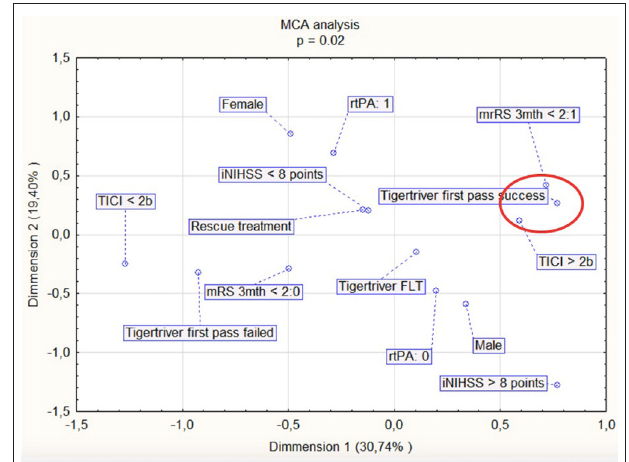
FIGURE 3 | Multiple correspondence analysis (MCA) for factors associated with an improved mRS (modified Rankin Scale) at 3 months (encircled in red). iNIHSS, NIHSS at admission; Tigertriever FLT, first line Tigertriever treatment.